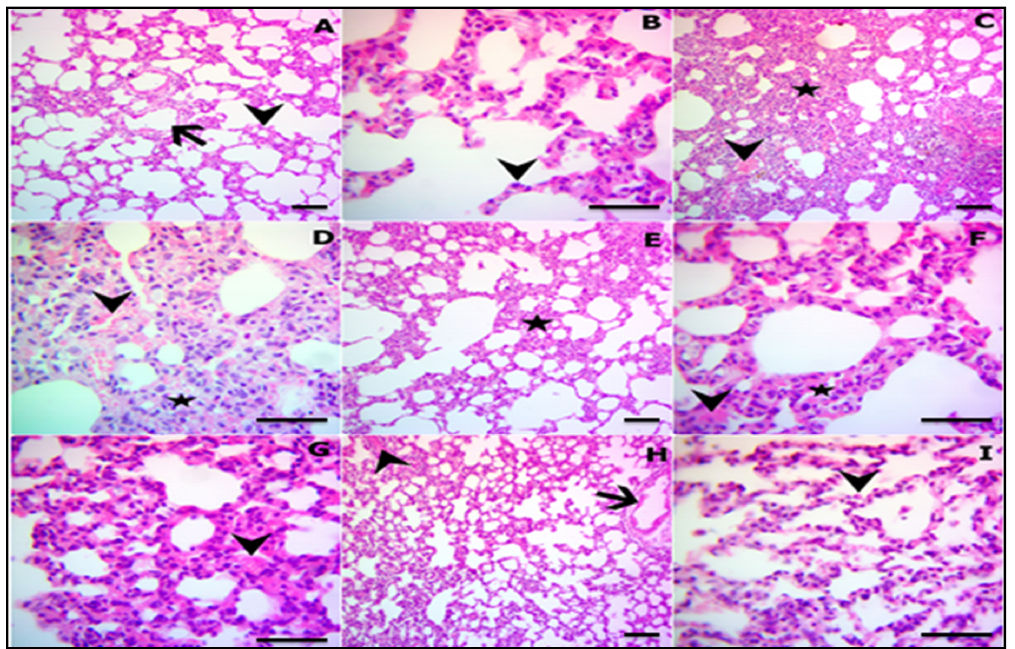
Figure 1. Representative photomicrograph of the H&E-stained lung sections in control ( A ) and CUR groups ( B ) showing normal pulmonary parenchyma, air bronchioles, and blood vessels (arrow) with apparently normal alveolar septa (arrowhead) ( A ), and normal pneumocytes (arrowhead) ( B ). ( C – G ) CP-induced rats showing complete obstruction of the alveoli, thickened interalveolar septa (star), engorged blood vessels (arrowhead) ( C ), severe edema admixed with extravasated erythrocytes in the interalveolar septa (arrowhead), infiltration of inflammatory cells mainly lymphocytes and few granulocytes (star) ( D ), marked compensatory emphysema combined with thickened septa (star) ( E ), prominent interstitial edema (arrowheads), inflammatory cells aggregations, and thickened septa ( F , G ). ( H , I ) CP-induced rats pretreated with CUR showing restoration of the majority of lung structures, including airways (arrow) with still mlid congested blood vessels (arrowhead) ( H ), remodeled alveolar septa characterized by empty lumen and single row of pneumocytes (arrowhead) ( I ). ( A , C , E , H X100; B , D , F , G , I X400).